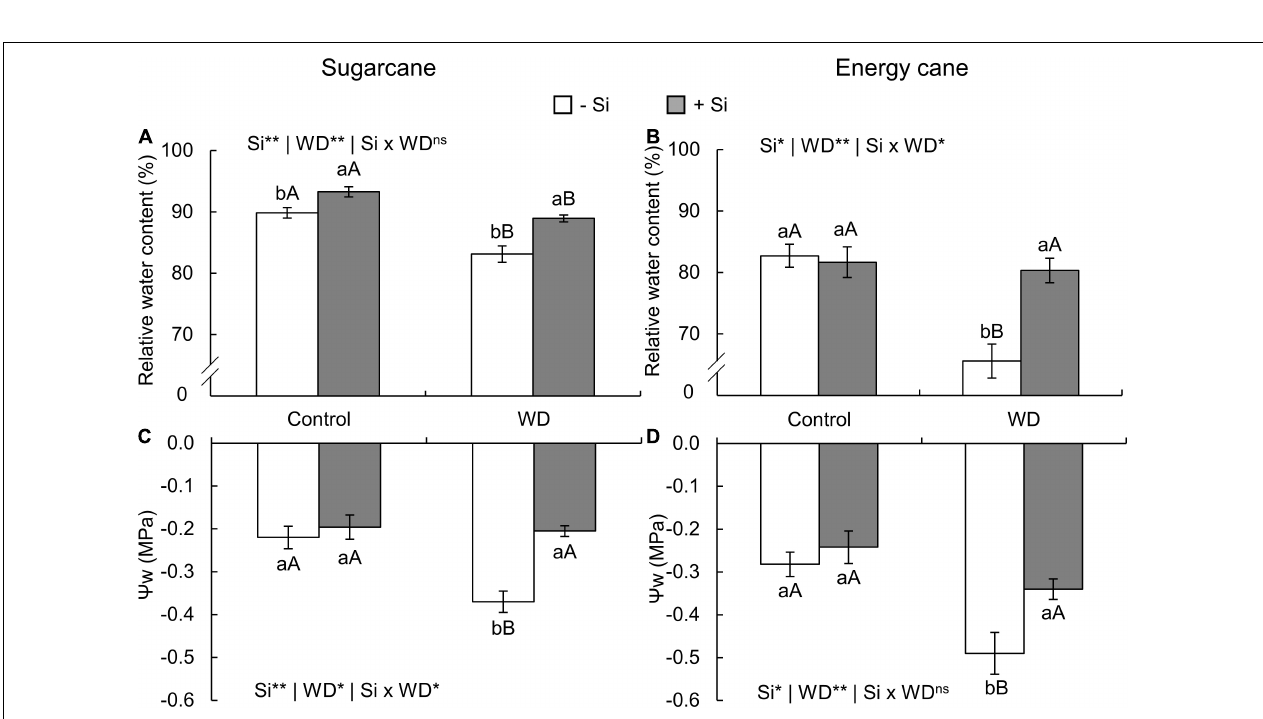
FIGURE 8 | Relative water content and (cid:57) w in sugarcane (A,C) and energy cane plants (B,D) in -Si and + Si under adequate water regime (control) and in WD for a period of 7 to 160 days after transplantation. ** and * significant with 1 and 5% probability, respectively, and ns, not significant by the F -test. Lowercase letters indicate differences in relation to Si and capital letters in relation to water deficit. n = 5. Si × WD: interaction.